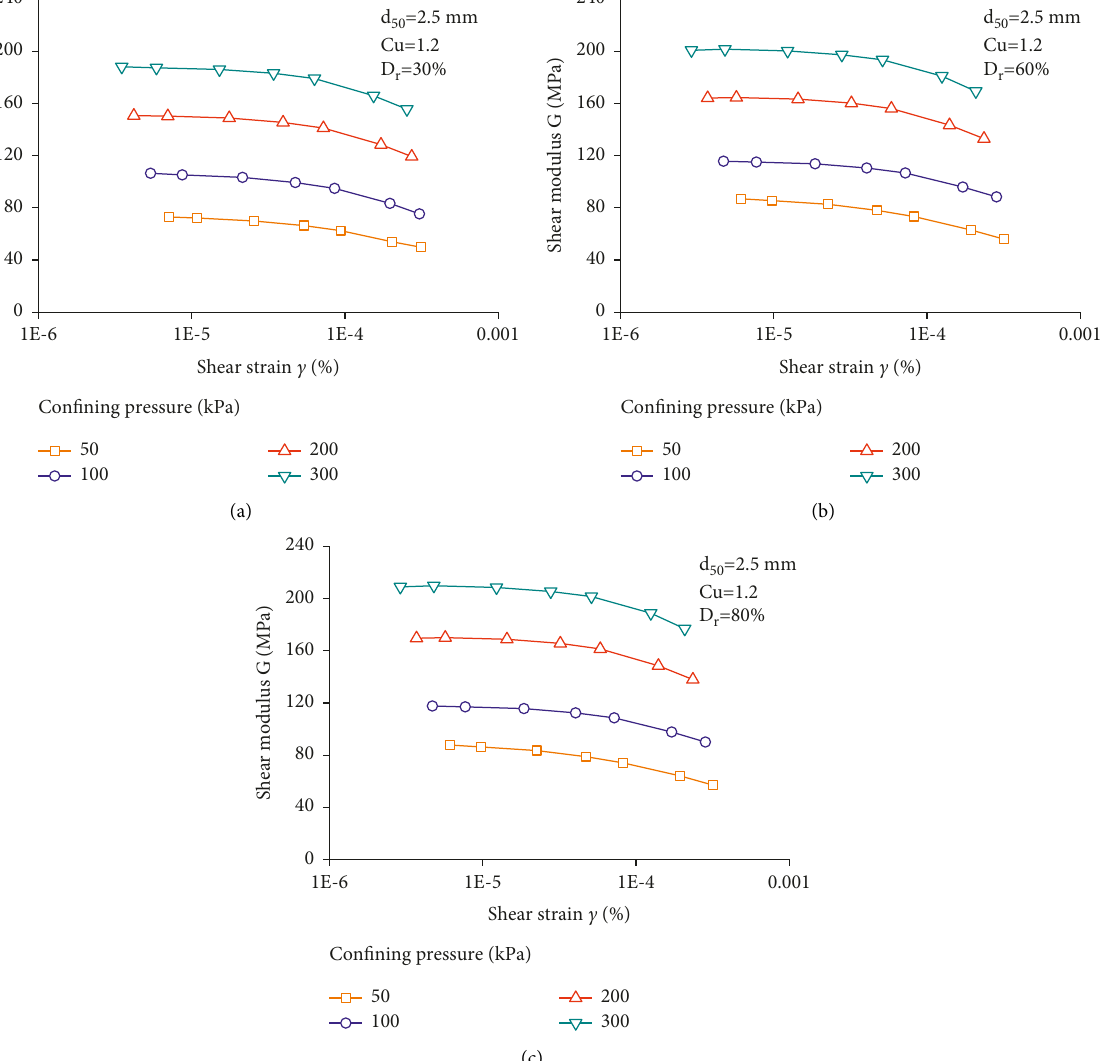
� 2.5mm and Cu � 1.2 at different confining pressures. (a) Loose 50